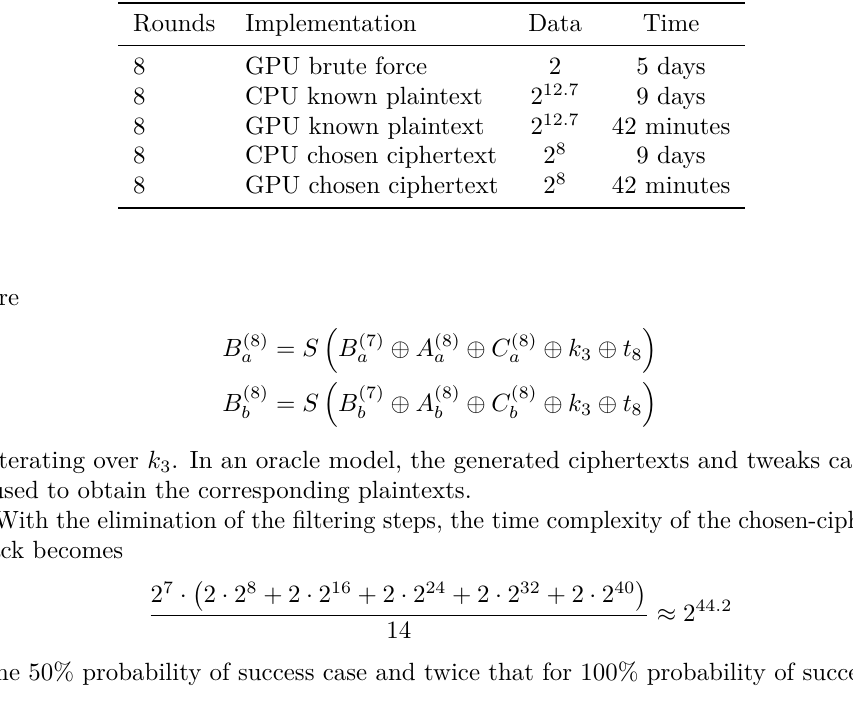
Table 4: Summary of implemented attacks and the times required to perform attacks with data for 50% success